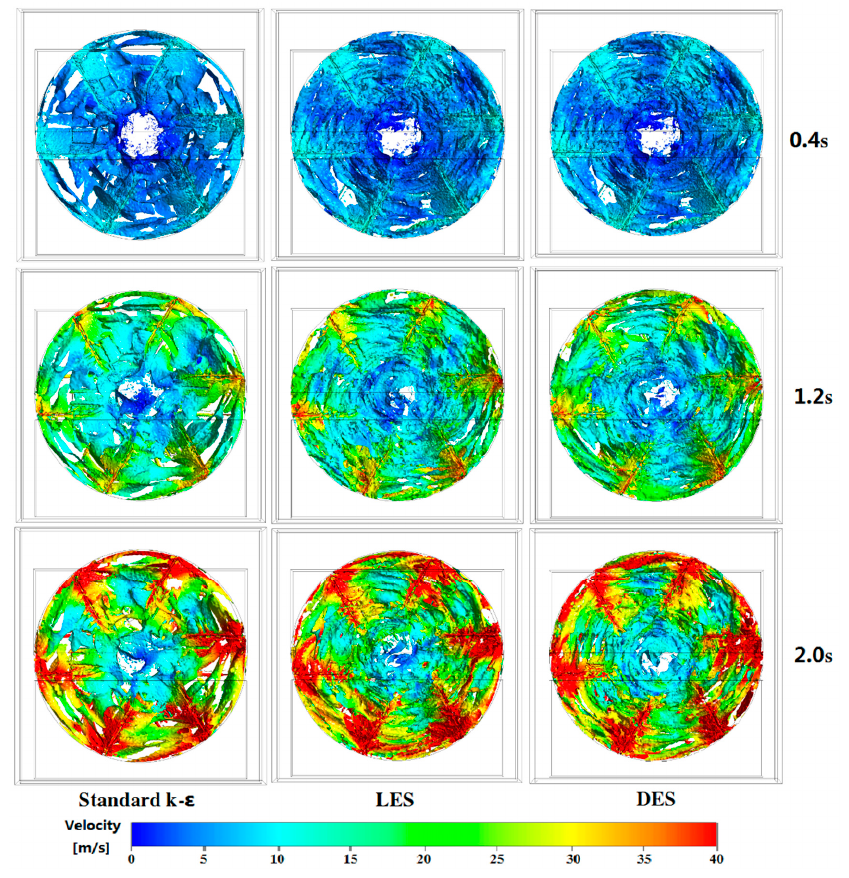
Figure 9. Vortex structures of the fan.